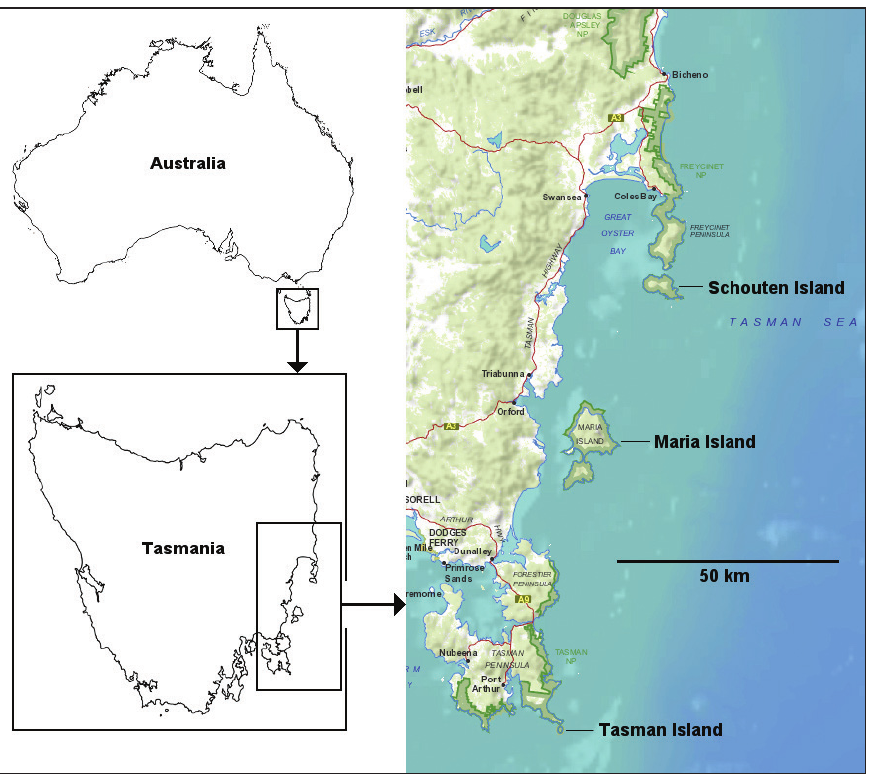
Figure 3. Outline maps of Australia and Tasmania, and topographic map of part of the east coast of Tasmania showing Schouten and Tasman Islands. Mercator projections; topographic basemap from the Land Information Service Tasmania (LIST), copyright State of Tasmania, used with